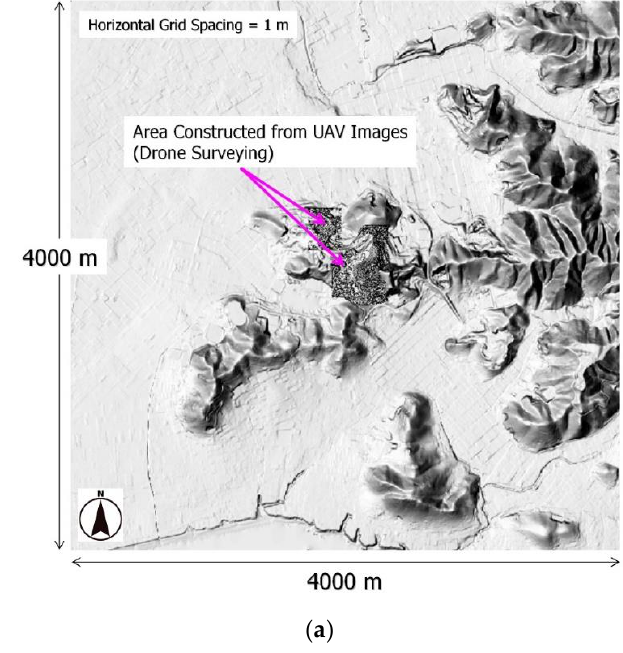
Figure 6. Construction of high-resolution elevation data with a drone.